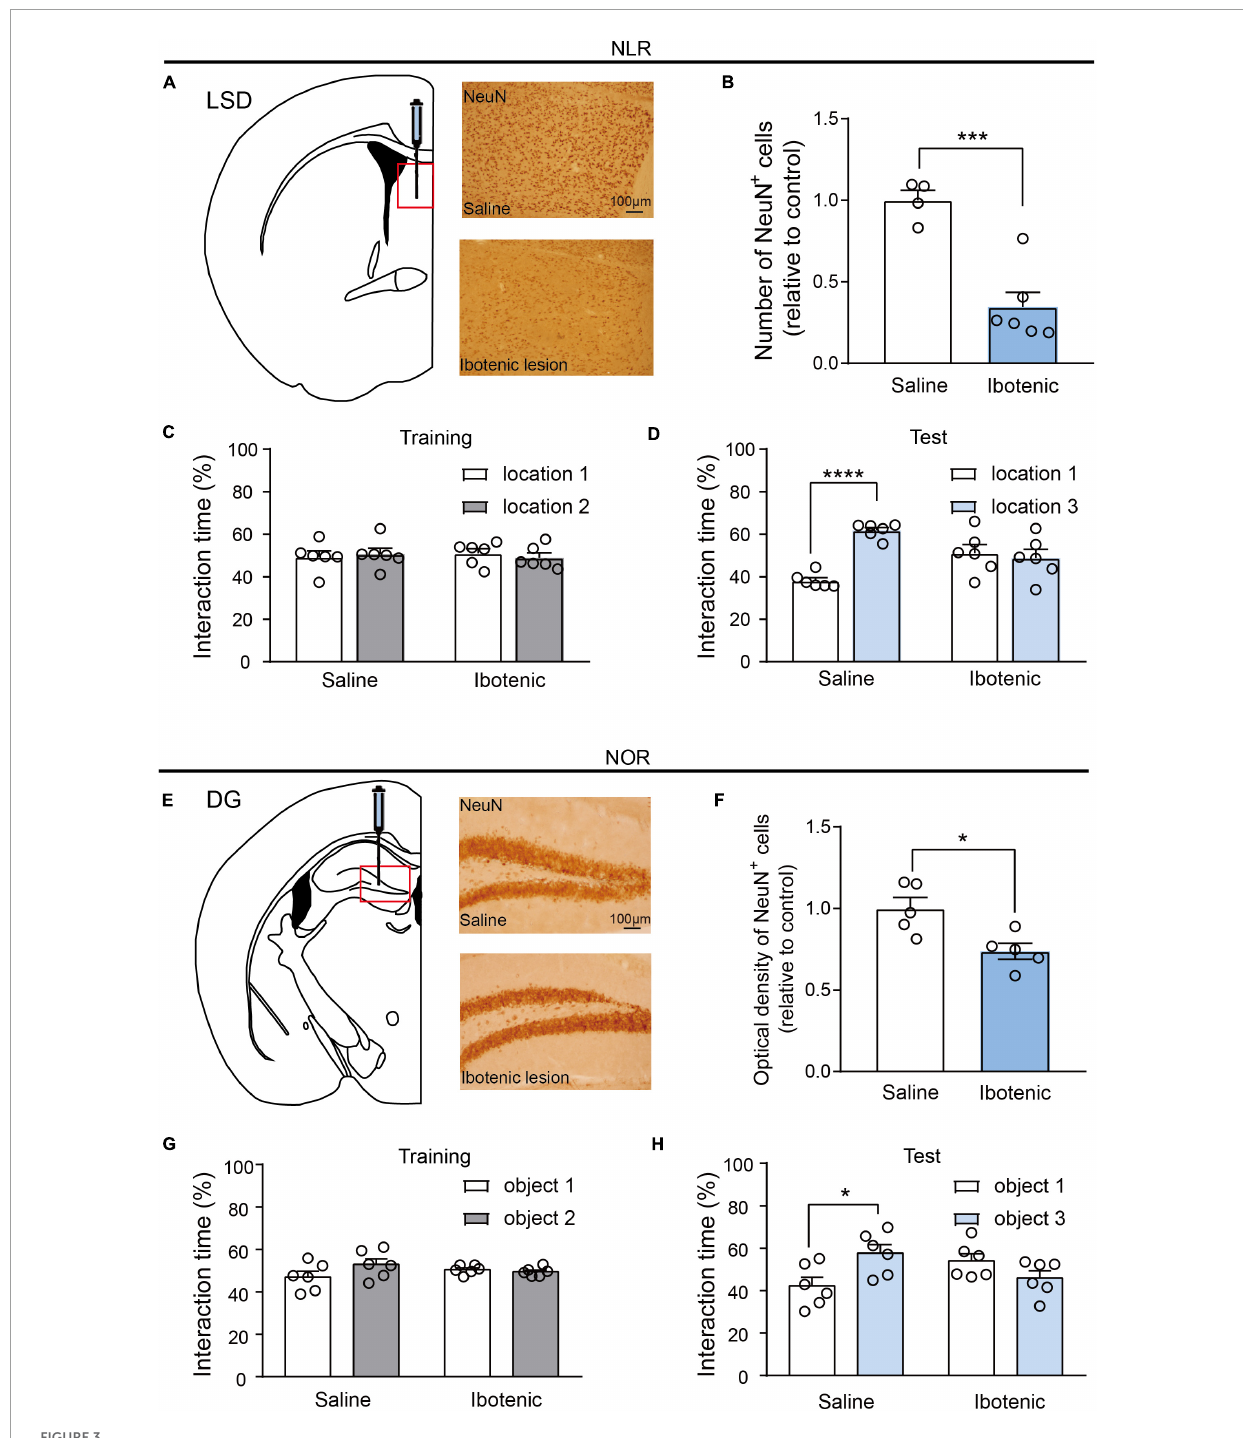
FIGURE3 Lesions of LSD and DG induced by ibotenic acid contributed to deficits in spatial and object recognition memory. (A) Representative images of NeuN-positive cells in the LSD of saline and ibotenic lesioned mice. Scale bar, 100 µ m. (B) The number of NeuN positive cells in the LSD of experiment mice. Ibotenic lesioned mice showed decreased neurons in LSD compared with saline mice (saline: n = 4; Ibotenic: n = 6). Unpaired t -test: t ( 8 ) = 5.342, *** p = 0.0007. (C) The interaction time (%) of NLR during the training phase in saline ( n = 6) and ibotenic lesioned mice ( n = 6). Unpaired t -test: saline: t ( 10 ) = 0.3271, p = 0.7504; Ibotenic: t ( 10 ) = 0.6613, p = 0.5234. (D) The interaction time (%) of NLR during the test phase. Saline mice showed more preference for the novel location compared with the familiar location ( n = 6). Unpaired t -test: t ( 10 ) = 12.05, **** p < 0.0001. Ibotenic-lesioned mice showed no significant difference between the two locations. Unpaired t -test: t ( 10 ) = 0.396, p = 0.7004. (E) Representative images of NeuN-positive cells in the DG of saline and ibotenic lesioned mice. Scale bar, 100 µ m. (F) The optical density of NeuN positive cells in the DG of experiment mice. Ibotenic lesioned mice showed decreased neurons in DG compared with saline mice (saline: n = 5; Ibotenic: n = 5). Unpaired t -test: t ( 8 ) = 3.111, * p = 0.0144. (G) The interaction time (%) of NOR during the training phase in saline ( n = 6) and ibotenic lesioned mice ( n = 6). Unpaired t -test: saline: t ( 10 ) = 2.020, p = 0.0710; Ibotenic: t ( 10 ) = 0.8544, p = 0.4129. (H) The interaction time (%) of NOR during the test phase. Saline mice showed more preference for the novel object compared with the familiar object ( n = 6). Unpaired t -test: t ( 10 ) = 2.863, * p = 0.023. Ibotenic-lesioned mice showed no significant difference between the two objects. Unpaired t -test: t ( 10 ) = 1.680, p =